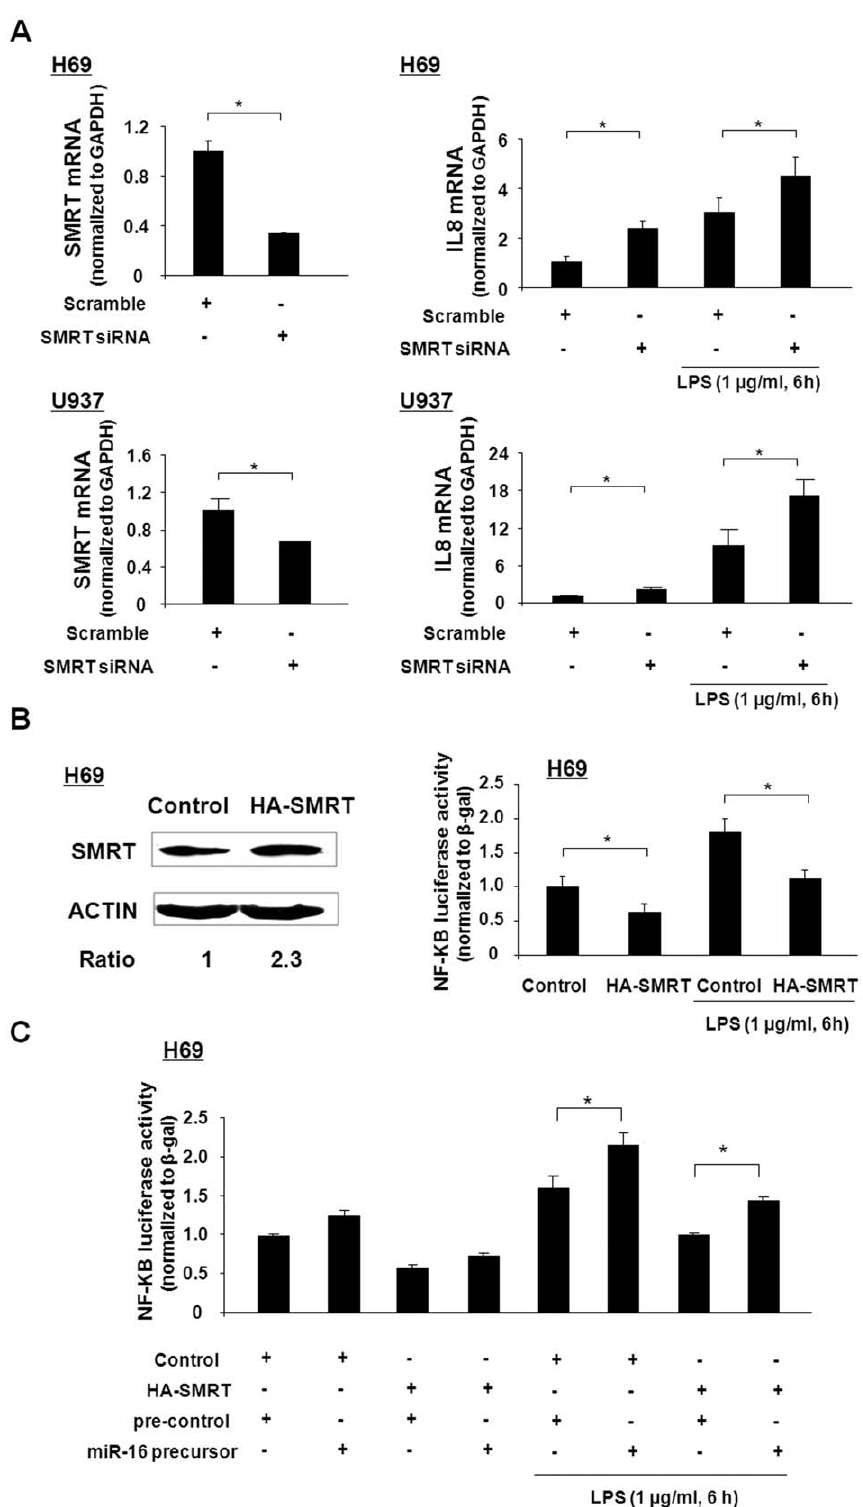
Figure 7. Functional manipulation of SMRT influences NF- k B-regulated transcriptional activity induced by LPS. (A) Effects of SMRT knockdown on LPS-induced IL-8 expression in H69 and U937 cells. Knockdown of SMRT by siRNA was confirmed by real-time PCR analysis. H69 and U937 cells were transfected with the scramble control siRNA or SMRT siRNA for 48 h, followed by an additional 6 h incubation in the presence or absence of LPS (1 m g/ml). Levels of IL-8 mRNA were quantified by real-time PCR. (B) Overexpression of SMRT attenuated LPS-stimulated NF- k B activation in H69 cells. Transfection of H69 cells with the HA-SMRT construct for 24 h increased SMRT expression level by about 2-fold. When cells were co-transfected with full-length SMRT and the NF- k B-driven IL-8 luciferase reporter constructs for 24 h, and then exposed to LPS for 6 h (1 m g/